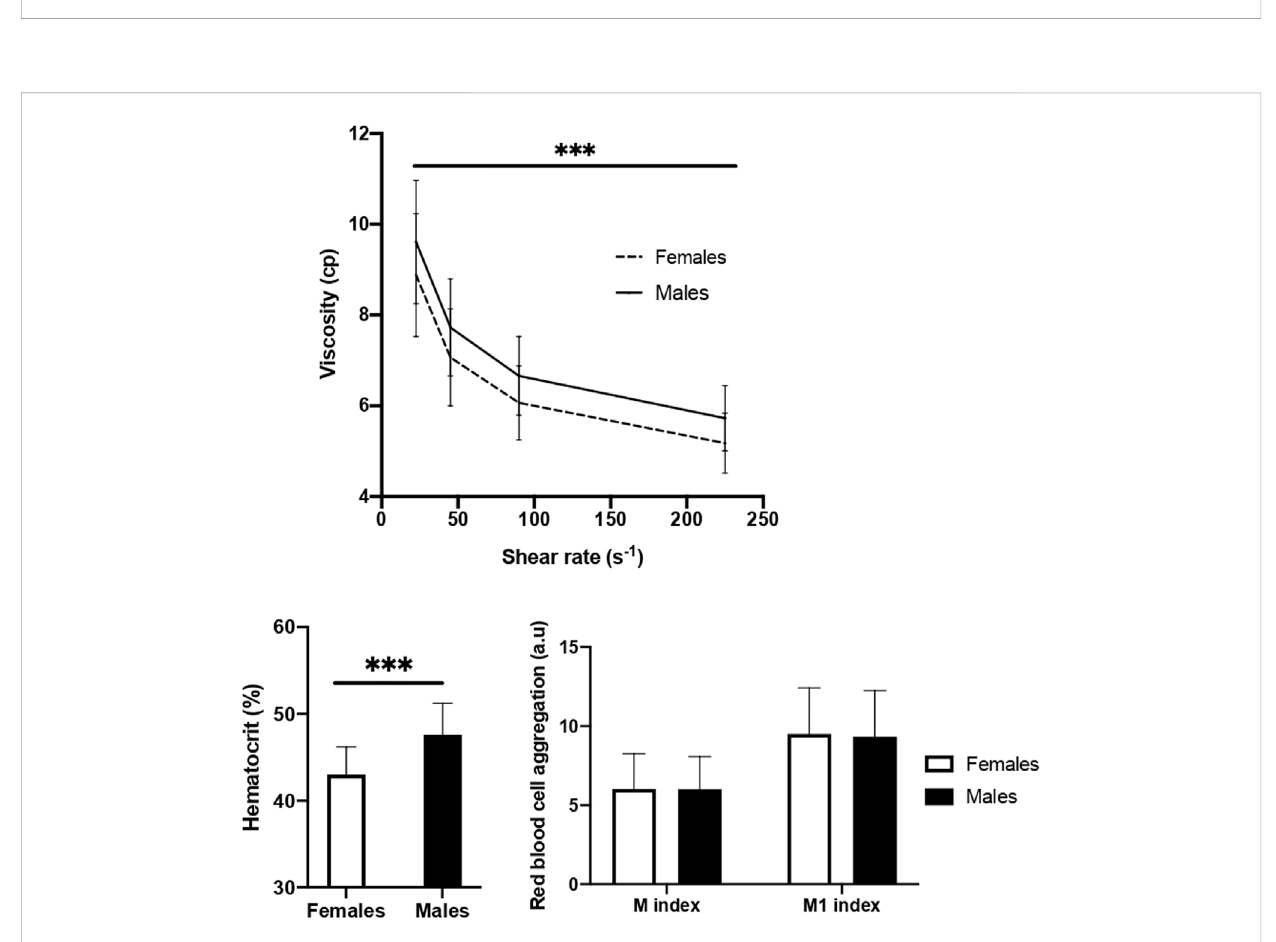
FIGURE 3 Blood viscosity and its determinants. Data are mean ± SD. M index: aggregation at stasis, M1 index: aggregation at low shear rate. Signi fi cantly different between males and females *** p < 0.001.